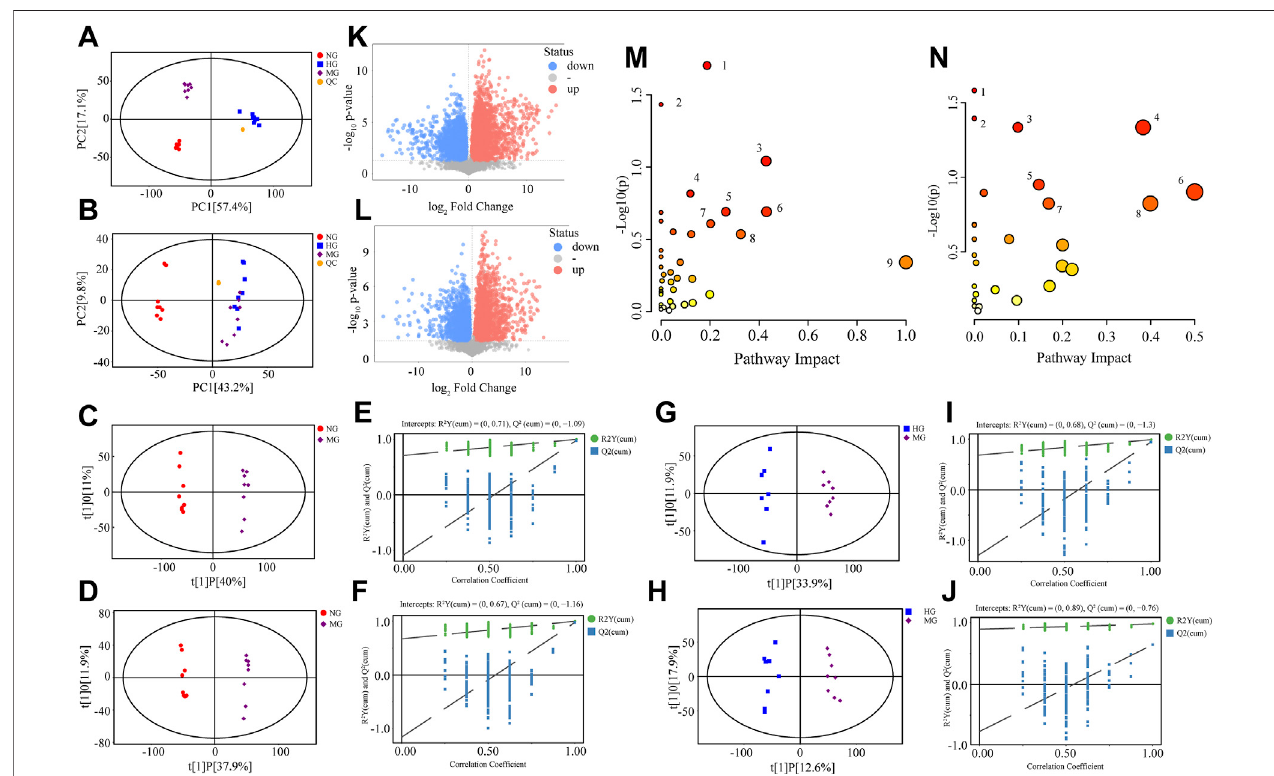
FIGURE 3 | Metabolomics analysis of NG, MG, and HG. PCA score plots in positive mode (A) and negative mode (B) ; OPLS-DA score plots for NG vs. MG in positivemode (C) and negativemode (D) ; permutationtest of OPLS-DA model for NGvs. MG in positive mode (E) and negativemode (F) ; OPLS-DA score plotsfor HG vs. MGinpositivemode (G) and negativemode (H) ;permutationtestofOPLS-DAmodelforHGvs.MGinpositivemode (I) andnegativemode (J) ;volcanoplotsforNG vs. MG in positive mode (K) and negative mode (L) ; (M) overview of metabolic pathways changed by high fat diet: 1. Lysine degradation, 2. Linoleic